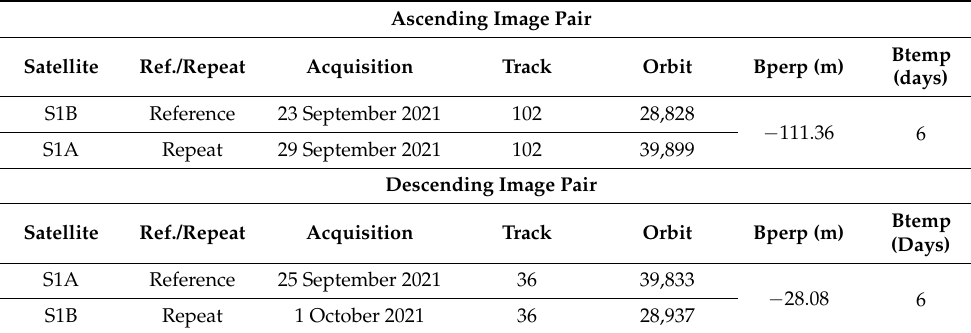
Table 3. The main characteristics of the SAR images used in this